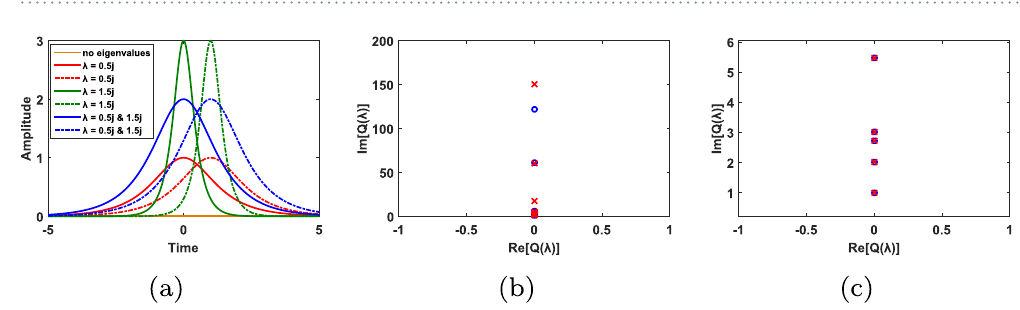
Figure 3. ( a ) Original eigenvalues at the transmitter (circle marks) and corresponding eigenvalues at the receiver(cross marks). All the waveforms here are generated with eigenvalues 1 i and 0.5 i . Eigenvalues suffer little distortion in transmission, which enables final signal recovery at the receiver. ( b ) Nonlinear spectral functions at the transmitter (circle marks) and at the receiver (cross marks). Different signals vary in their eigenvalues and spectral functions.